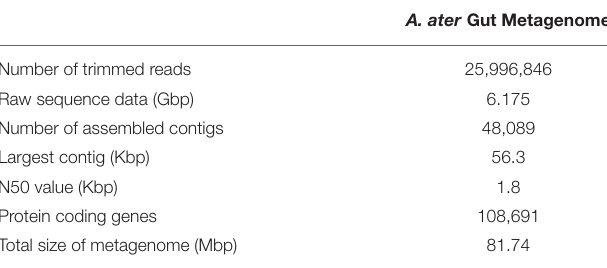
TABLE 1 | Sequencing and assembly statistics of the gut community